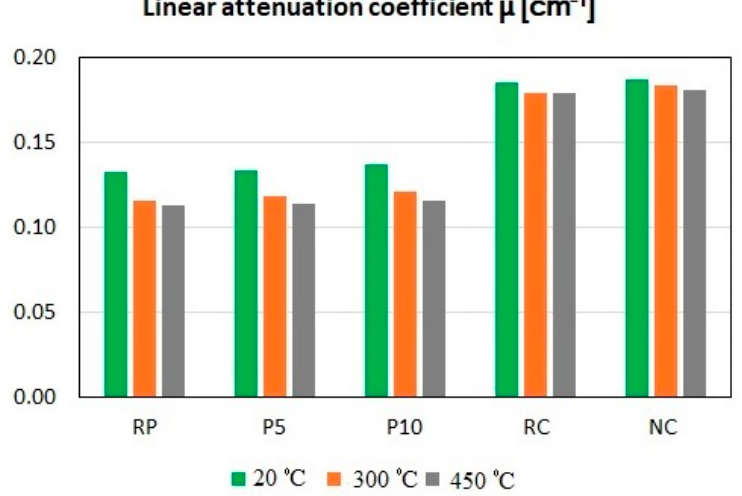
Figure 23. Linear attenuation coefficient µ for the tested cement pastes and concretes before and after exposure to 300 °C and 450 °C .